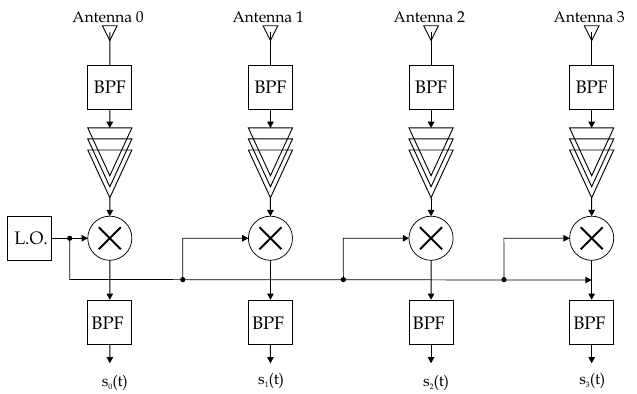
Figure 1. Block diagram depicting a 4-element ULA connected to a 4-channel RF front end with its basic sub-blocks for the amplification, down-conversion and band-pass filtering of the received signal, prior to the AoA